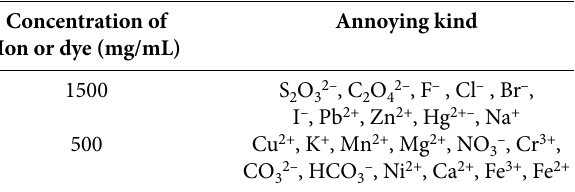
Table 2. Disturbance effect of various kinds of ions during the ad- sorption process. Concentration of